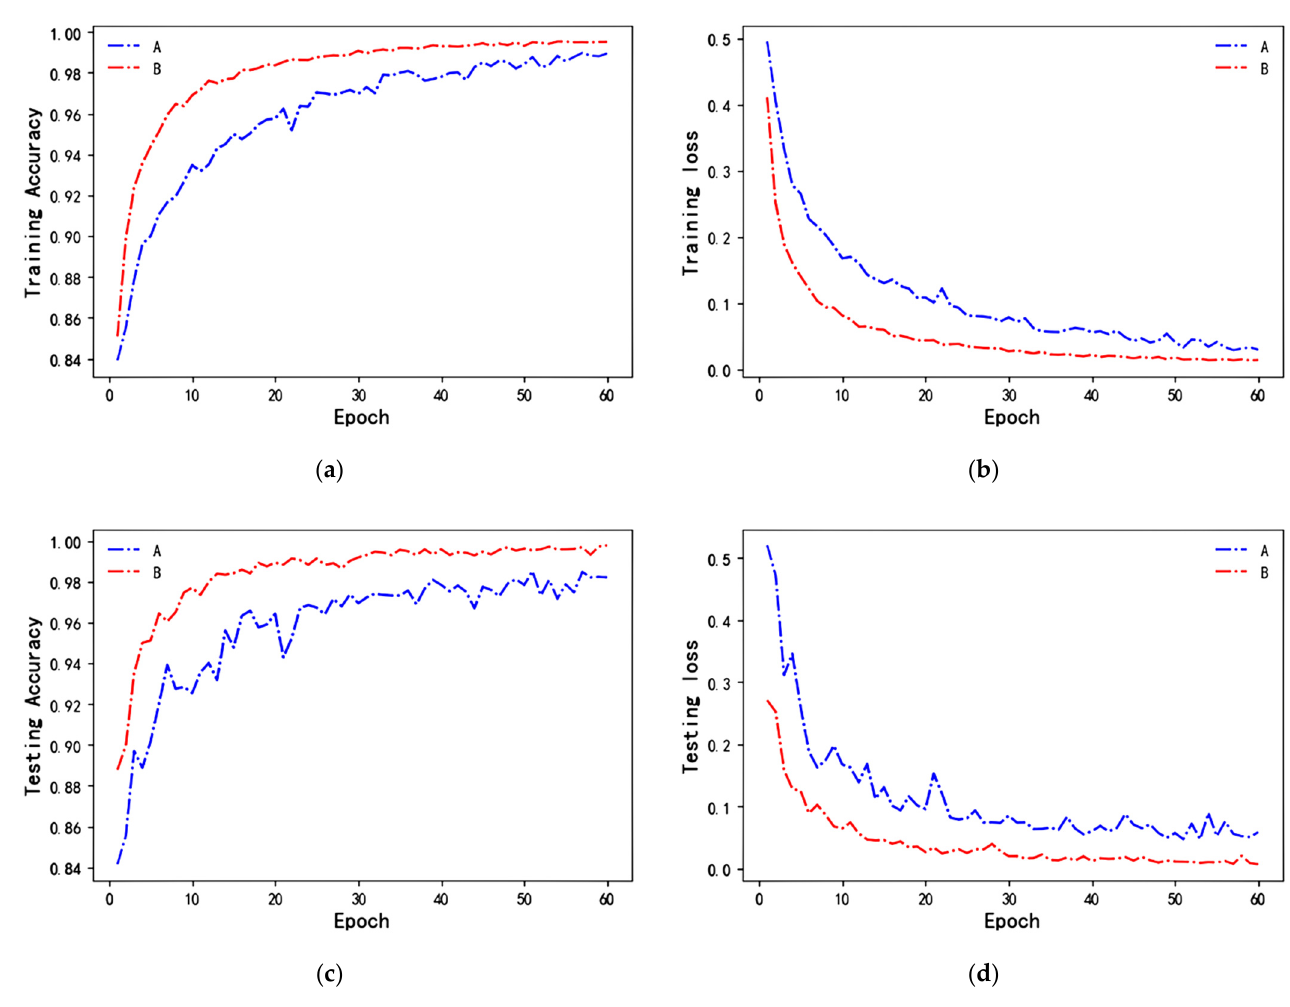
Figure 7. Training and testing accuracy and loss value curves of different datasets. ( a ) Training ac- curacy; ( b ) Training loss; ( c ) Testing accuracy; ( d ) Testing loss. accuracy; ( b ) Training loss; ( c ) Testing accuracy; ( d ) Testing